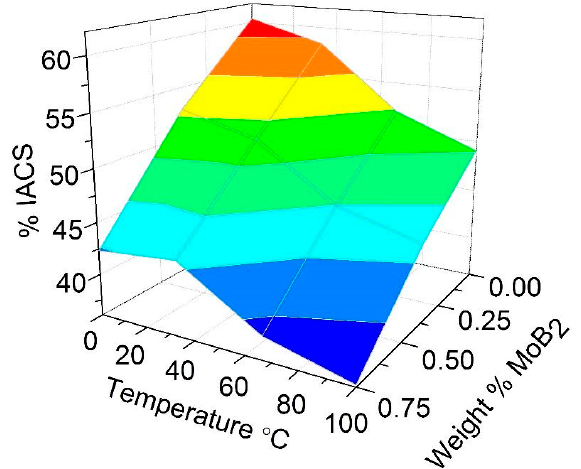
Figure 11. Measured electrical conductivity of the wires as a function of temperature and amount of MoB 2 .